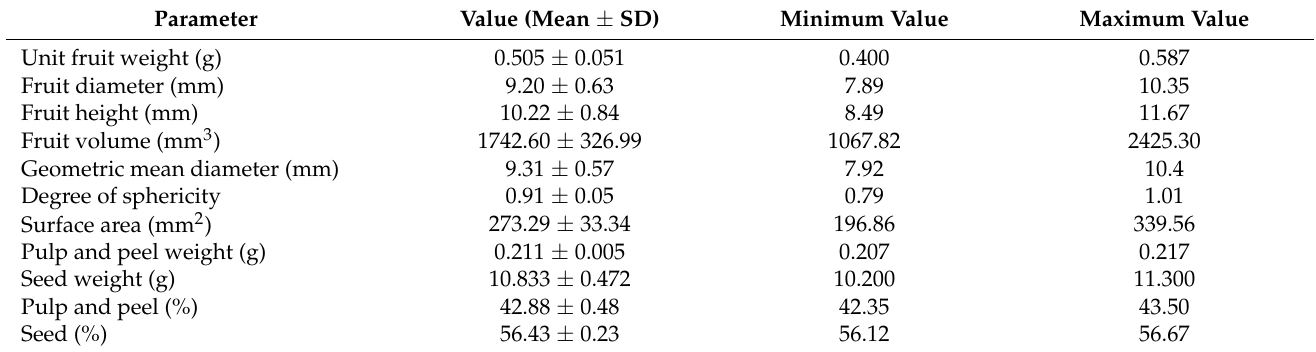
Table 7. Morphological parameters of hackberry fruits (mean ± SD, minimum and maximum value, n =